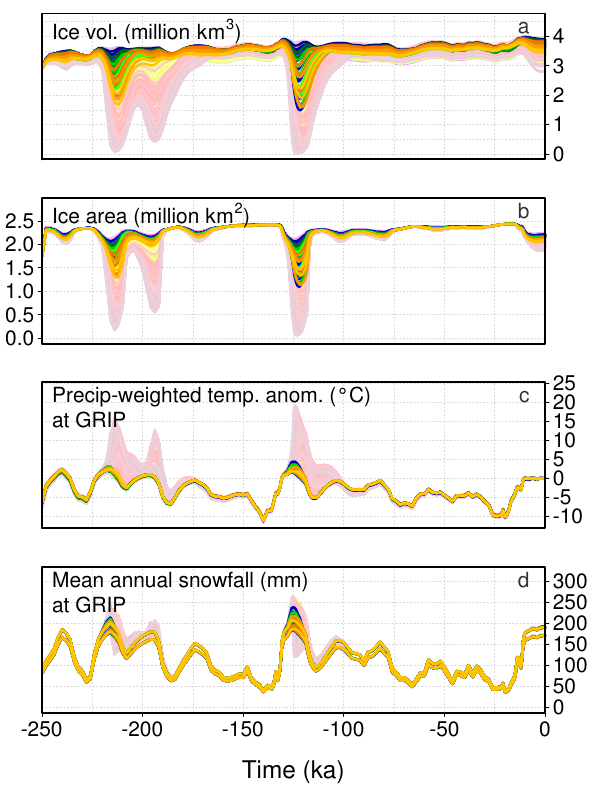
Fig. 3. Temporal evolution of (a) the volume and (b) the surface area of the GIS, as well as (c) the precipitation-weighted annual temperature anomaly at GRIP and (d) the annual snowfall at GRIP, as simulated by the ensemble of model versions. Lighter lines cor- respond to “invalid” simulations. Each color band is determined by the melt parameter c , as explained in the caption of Fig.